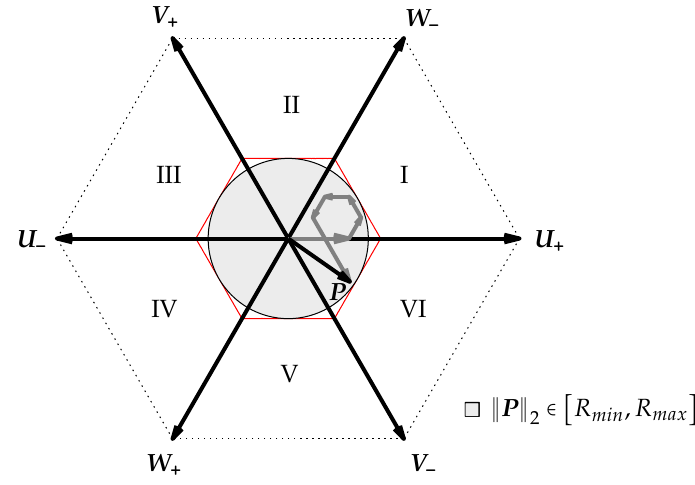
Figure 7. 6-Active SVM: The space vector P is formed by six fundamental space vectors ( t INF = 0.1). The 6-Active SVM allows six independent current slope measurements within a PWM